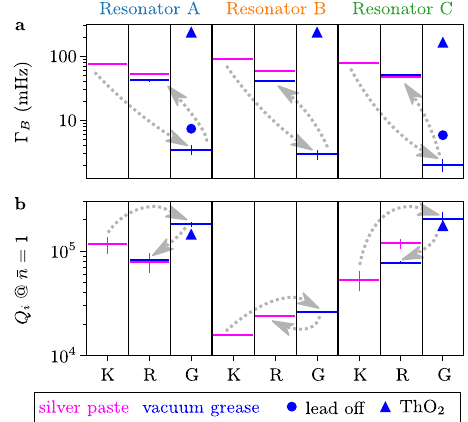
Fig. 3 Effect of ionizing radiation shielding on resonator performance.